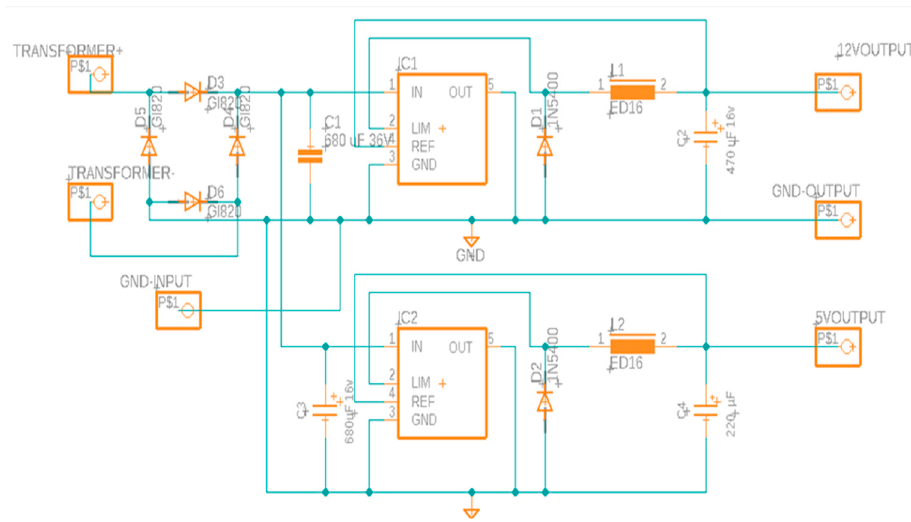
Figure 4. Power management circuit for the Dispensing and Positioning system of the